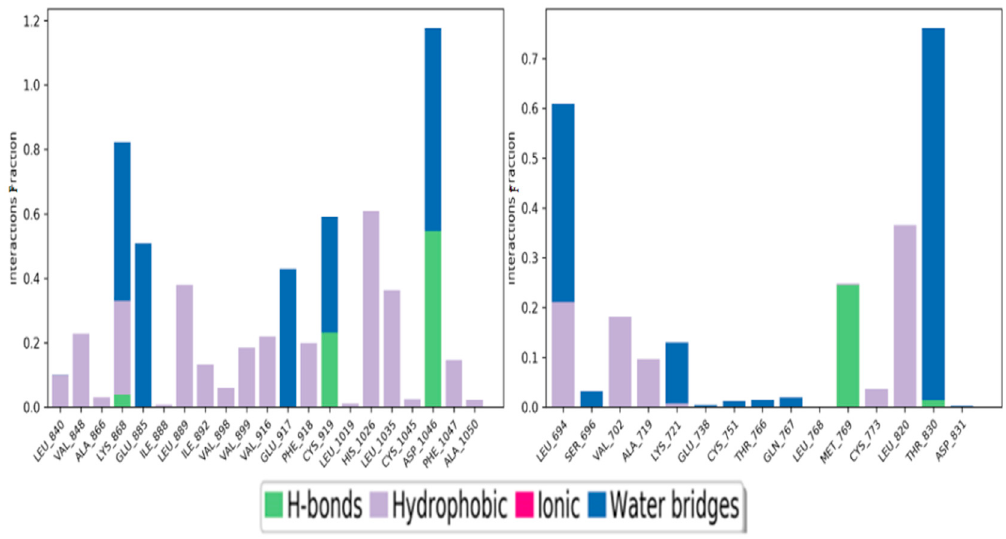
Figure 13. Protein-ligand contact histograms 7j-VEGFR 2 and 7j-EGFR showing various interac- tions.